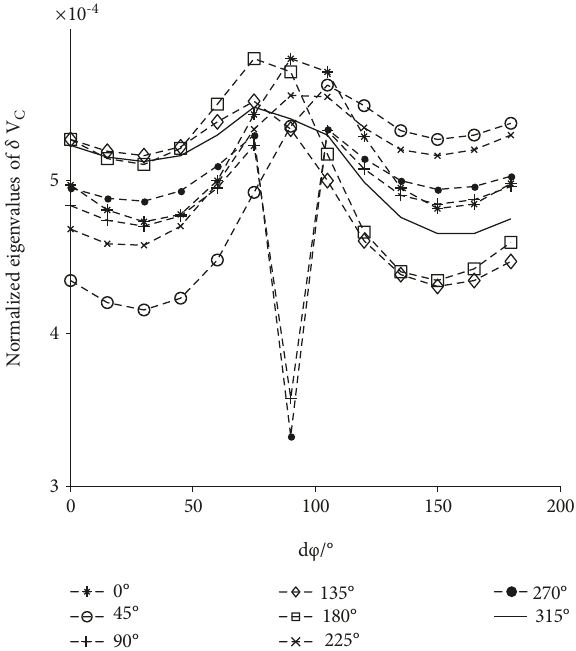
Figure 10: Normalized eigenvalues of the estimated current speed error under di ff erent current directions.